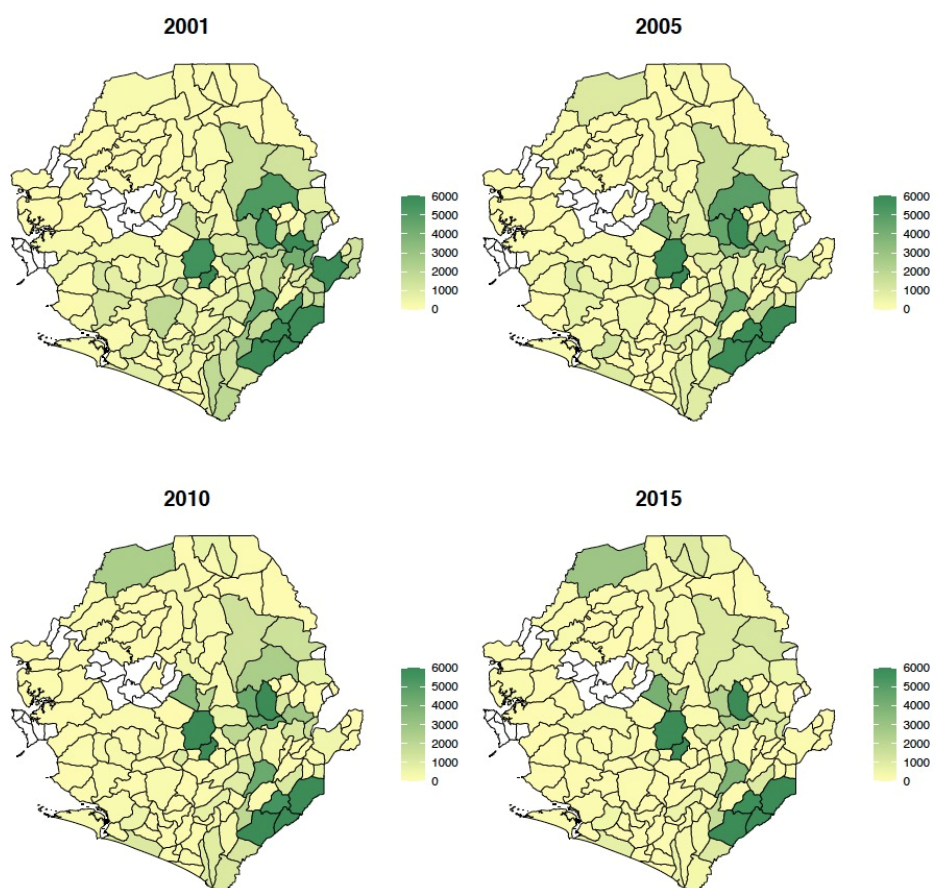
Figure 2. The summation of 23 values of sum forest NDVI over a year for each chiefdom in Sierra Leone in 2001, 2005, 2010, and 2015 (Locations in white are Western Area Urban and Western Area Rural that are not chiefdoms, and are 14 chiefdoms without forest cover shown in MODIS land cover data during 2001 and